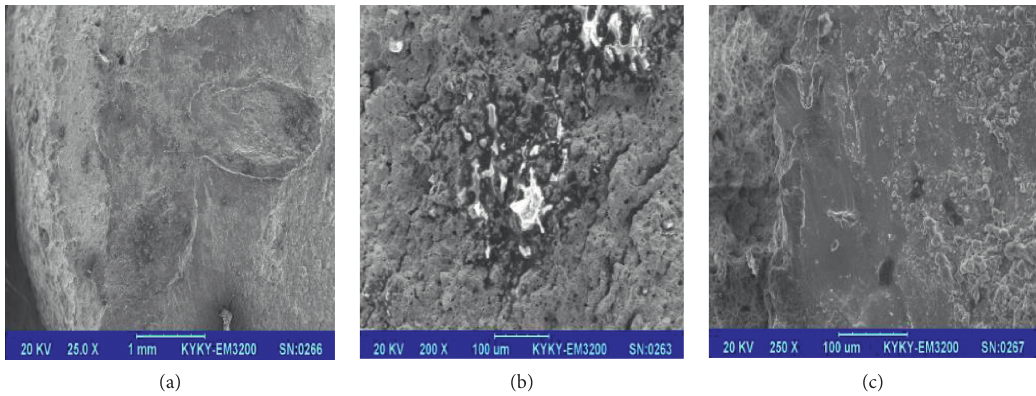
Figure 13: Steel fatigue failure surfaces of Beam 3. (a) Source zone. (b) Development zone. (c) Fracture zone.